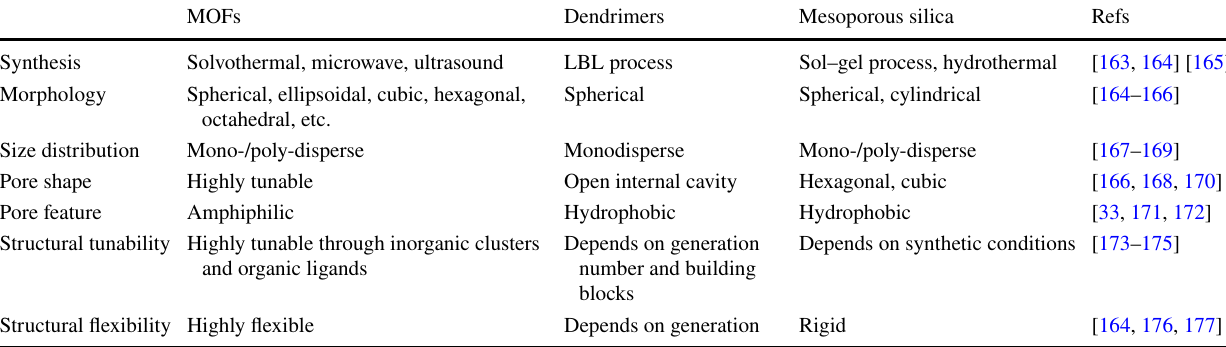
Table 1 Summary of the properties of MOF nanoparticles, dendrimers, and mesoporous silica